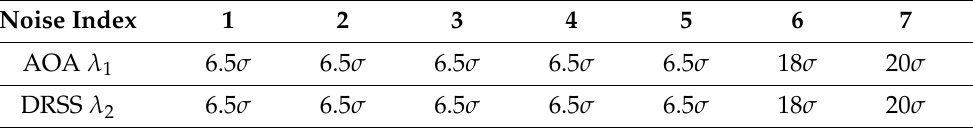
Table 2. λ 1 and λ 2 for